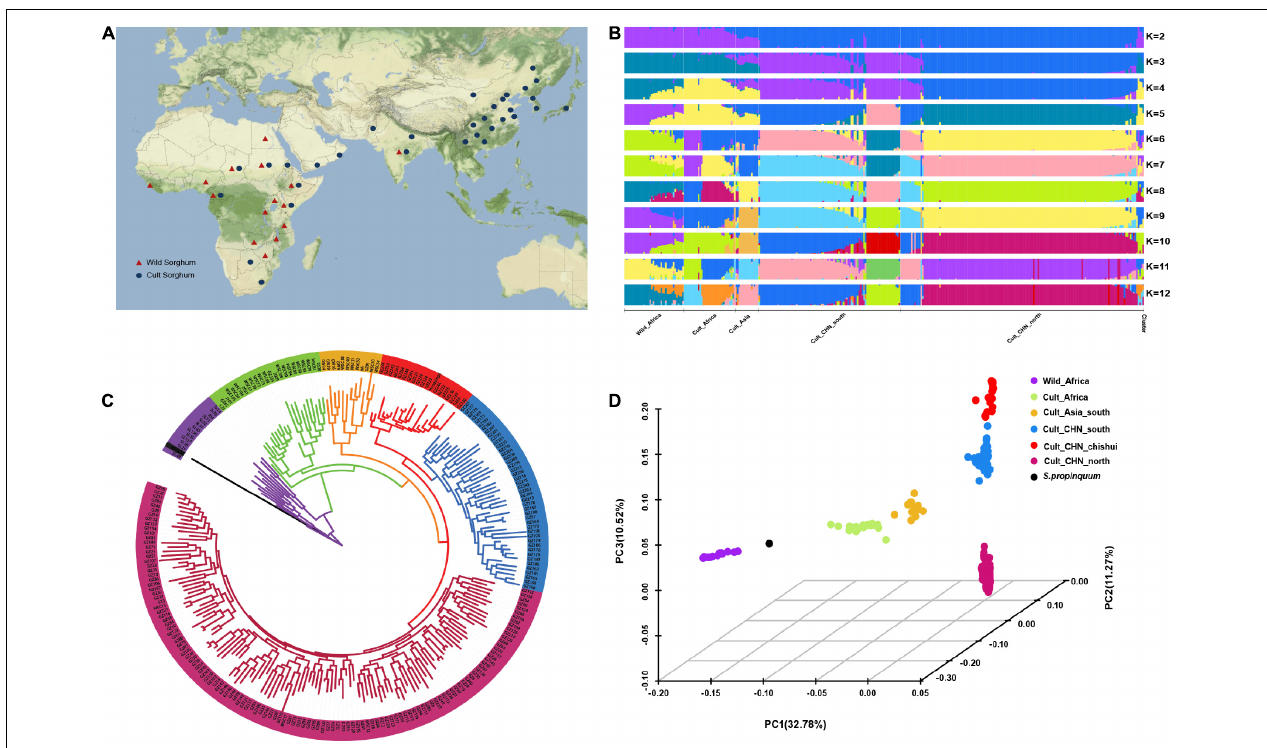
FIGURE 1 | Germplasm origin and population genetic analysis. (A) Geographic distribution of cultivated and wild sorghum accessions represented by red triangle and blue circle, respectively. (B) Genetic structure of sorghum accessions as inferred with structure for K = 2 to 12. (C) Neighbor-joining tree for sorghum accessions. The six subpopulations defined based on structures analysis are indicated by different colors. Purple, green, orange, red, blue, and rose indicate wild sorghum, and cultivated accessions from African, South Asian, Chinese Chishui, South and North China, respectively. (D) Principal component analysis of sorghum accessions, showing the first three principal components. The dot colors correspond to the phylogenetic tree